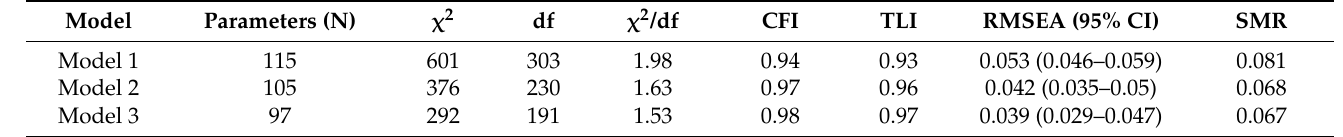
Table 2. Final confirmatory factor analysis models and their fit